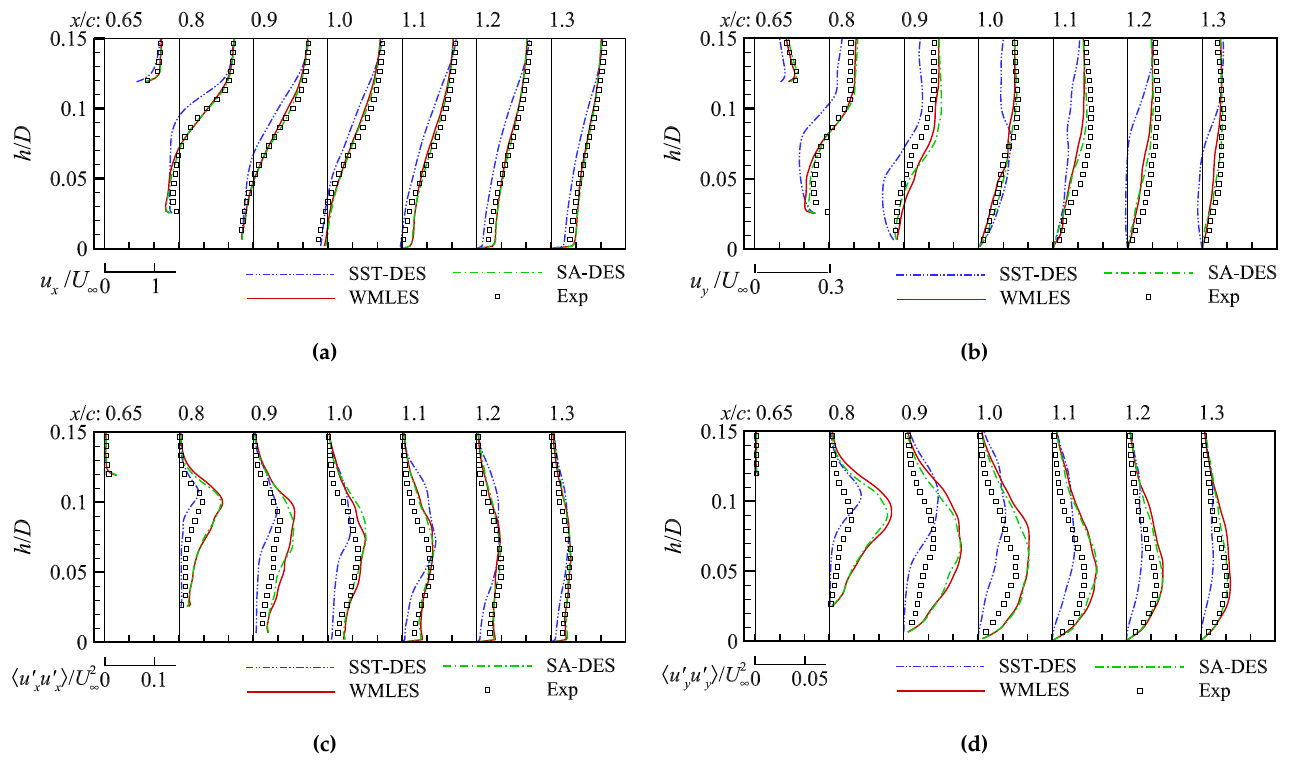
Figure 14. Mean velocity and mean resolved Reynolds stress profiles at x / c = 0.65, 0.8, 0.9, 1.0, 1.1, 1.2 and 1.3 in the wake region of hump: ( a ) mean streamwise velocity, ( b ) mean normal velocity, ( c ) mean resolved streamwise Reynolds stress, and ( d ) mean resolved normal Reynolds